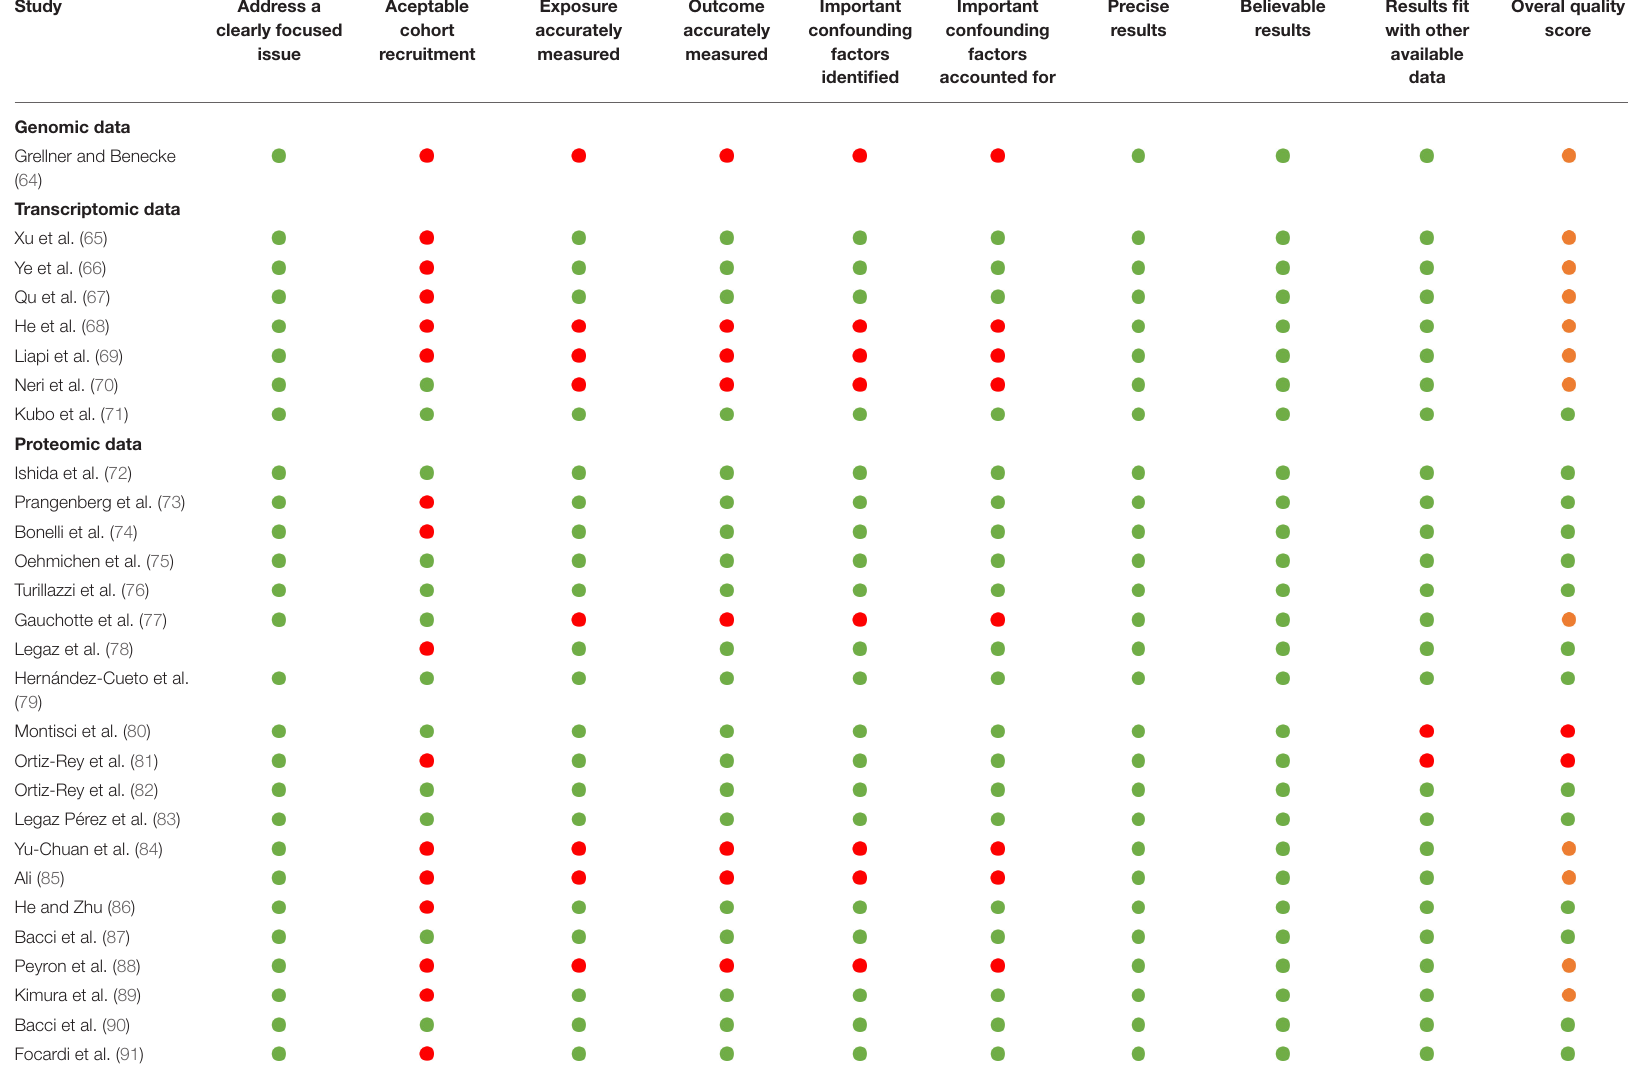
TABLE 2 | Risk of bias assessment: differentiation of vital and post-mortem wounds a